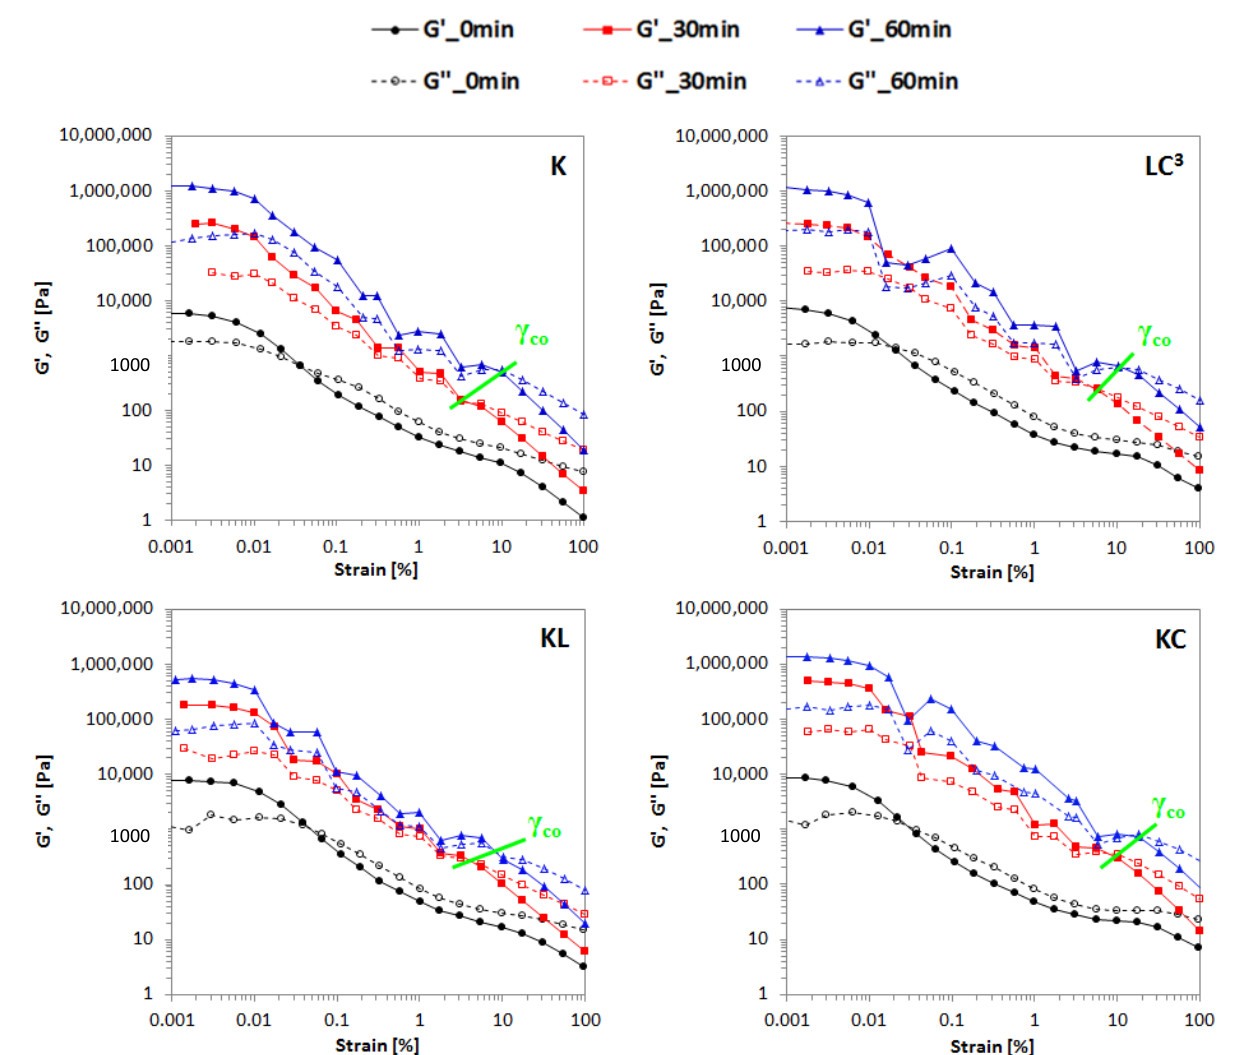
Figure 7. Storage (G′, solid line) and loss (G′′, dashed line) moduli vs. oscillation strain for binders at different resting times. γ co is the crossover point, when G′ = G″.